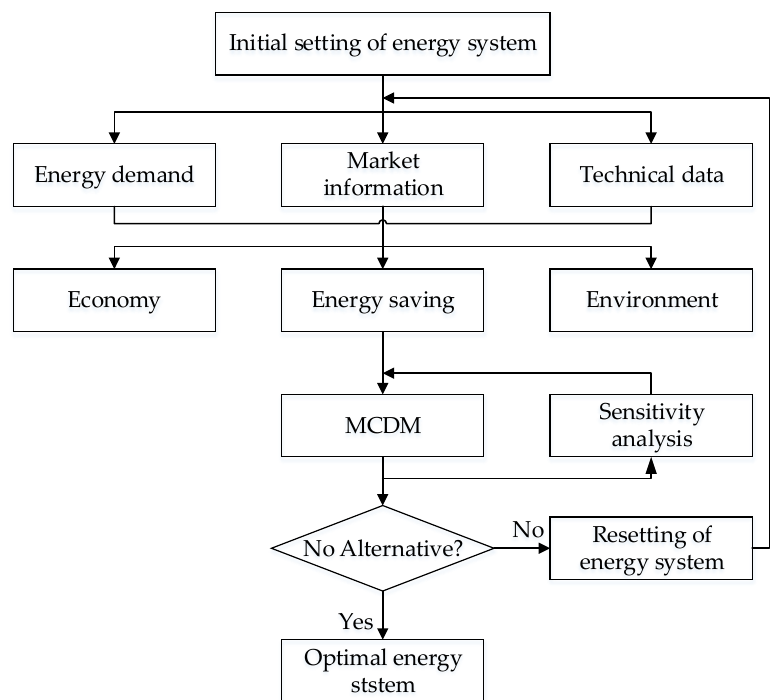
Figure 1. Flow chart of the multi-criteria decision-making (MCDM) model of energy systems.